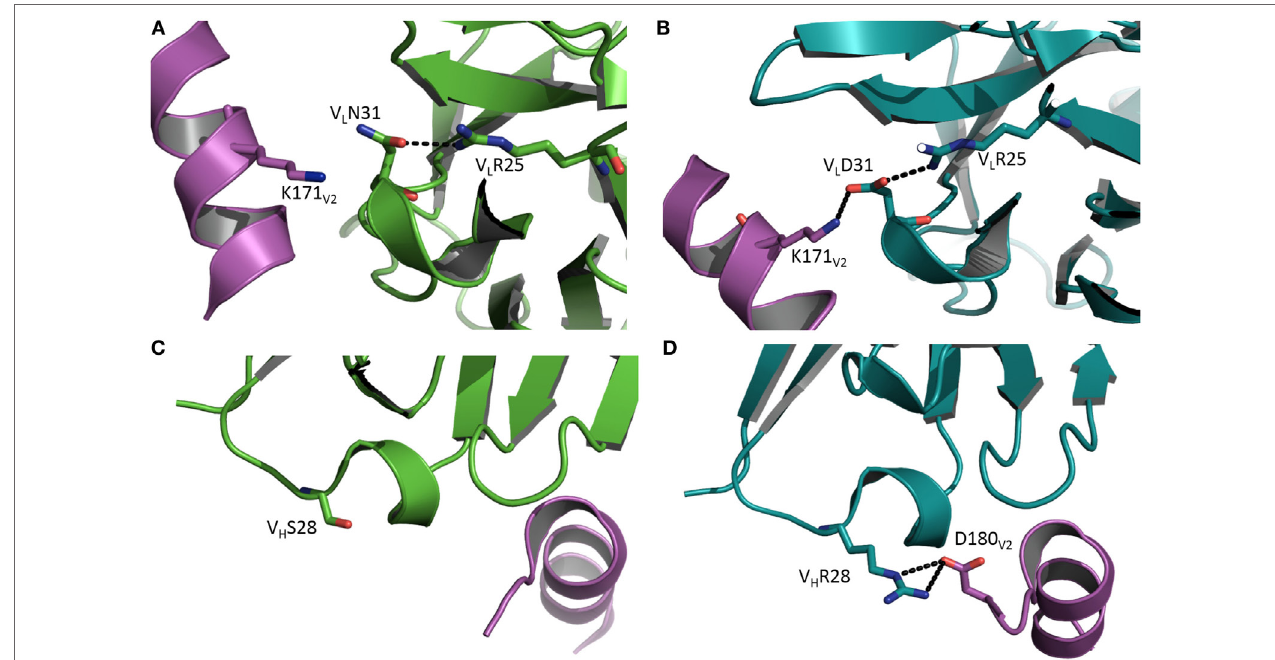
FiGURe 1 | Affinity maturation through formation of additional interactions with antigen. (A) Close-up view of the interface between the germ line precursor of antibody CH58 and the V2 peptide of HIV-1 envelope glycoprotein in the vicinity of V2 Lys171 (Protein Data Bank accession code 4RIS) (8). V L is green; V2 is magenta. (B) In affinity-matured CH58, the somatic mutation V L Asn31 → Asp allows formation of a stabilizing salt bridge (dotted black line) to V2 Lys171. V L is teal. (C) Close-up of the interface between the germ line precursor of CH58 and the V2 peptide in the vicinity of V H Ser28 (4HPO) (7). V H is green; V2 is magenta. (D) In affinity-matured CH58, the mutation V H Ser28 → Arg results in formation of a bidentate salt bridge with V2 Asp180. V H is teal. This residue was not visible in (C) due to disorder in the C-terminus of the V2